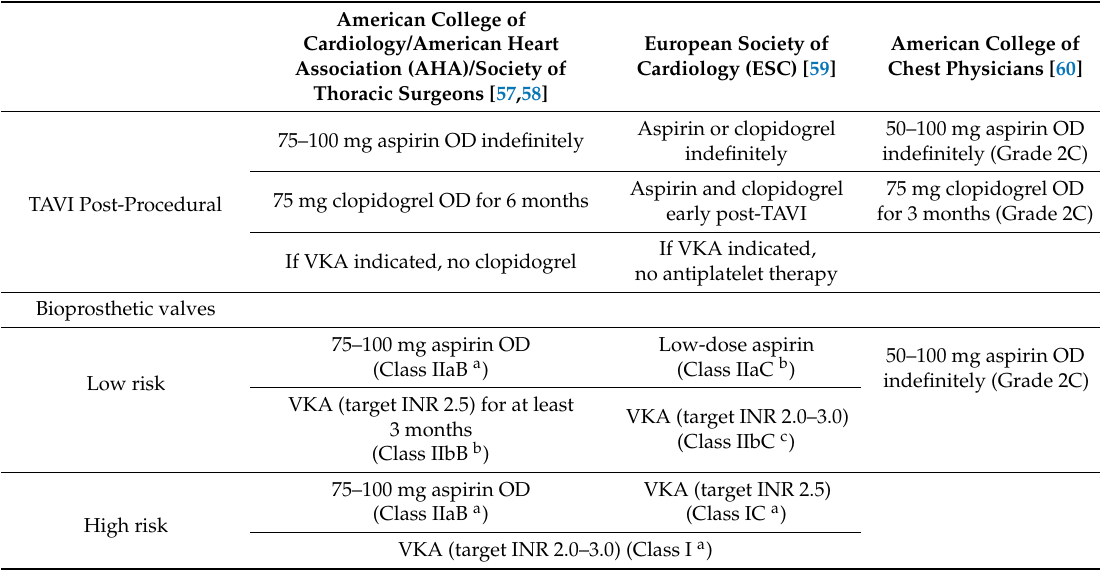
Table 2. Current antithrombotic guideline recommendations for patients undergoing